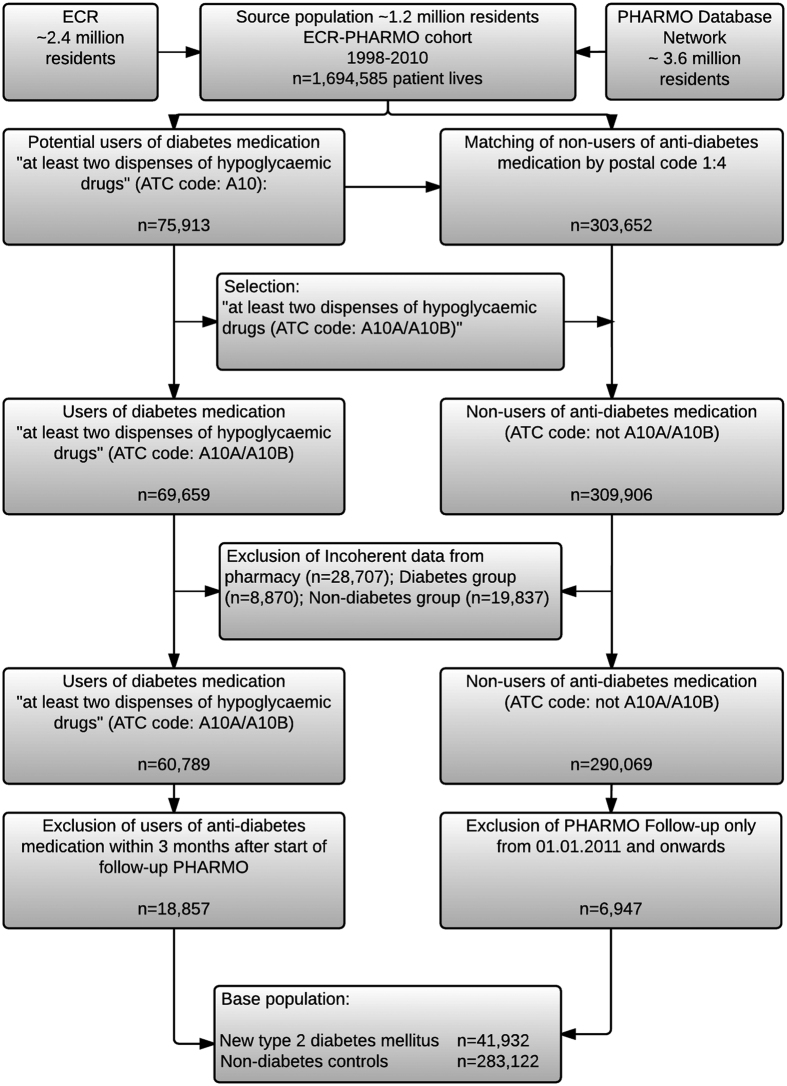
Study flowchart.